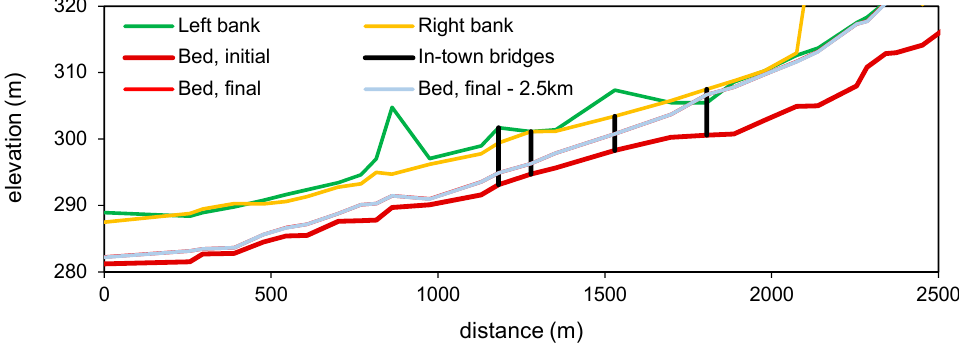
Figure 15. Model of the design flood scenario: sensitivity to the location chosen for a transition in sediment size (moved from 1.8 to 2.5 km).